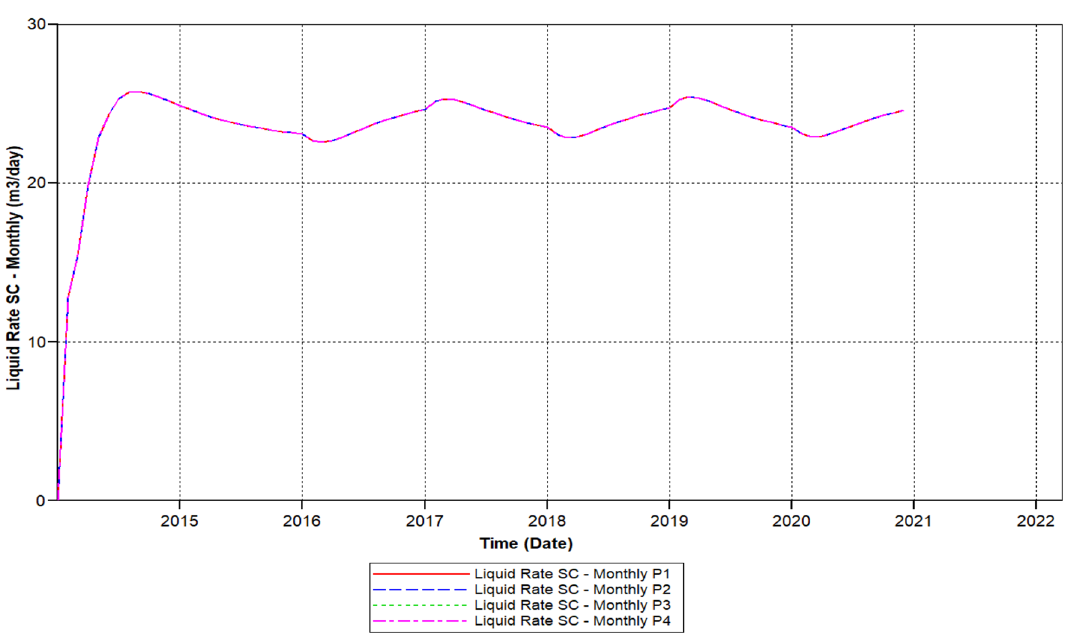
Figure 21. Shows the polymer sand plug model liquid ratio CMG STARS 2017.10 URL: https:// www. cmgl.